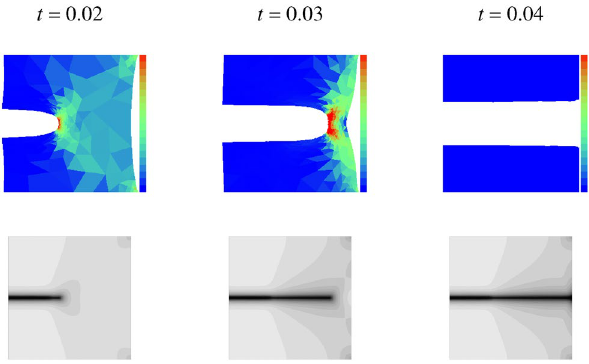
Fig. 4 Crack growth in an isotropic media with given boundary dis- placement g = ± t ( 0,10 ) on Γ ± (deformation (upper) and contour D lines of z (lower)). In the upper figures, blue color indicates low val- ues, red color high values of the intensity of